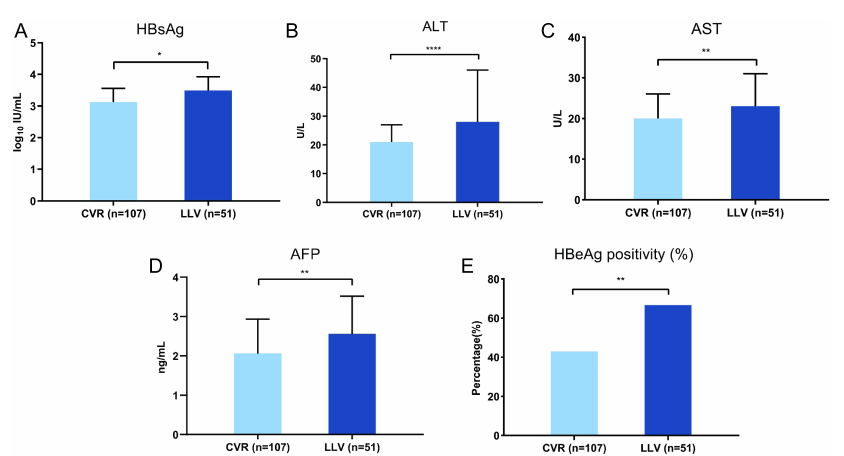
Figure 3. Comparison of HBsAg, ALT, AST and AFP levels and percentage of patients with HBeAg-positivity between CVR and LLV groups at the time point highly sensitive HBV DNA tests (LDL, 10 IU/mL) were performed. * P < .05; ** P < .01; **** P < .0001. CVR, complete virological response; LLV, low-level viremia; HBV, hepatitis B virus; LDL, lower detection limit; HBsAg, hepatitis B surface antigen; ALT, alanine aminotransferase; AST, aspartate aminotransferase; AFP, alpha fetoprotein; HBeAg, hepatitis B e antigen. Table 4. Laboratory Data of CHB Patients with CVR or LLV at the Time Point of Identifying LLV